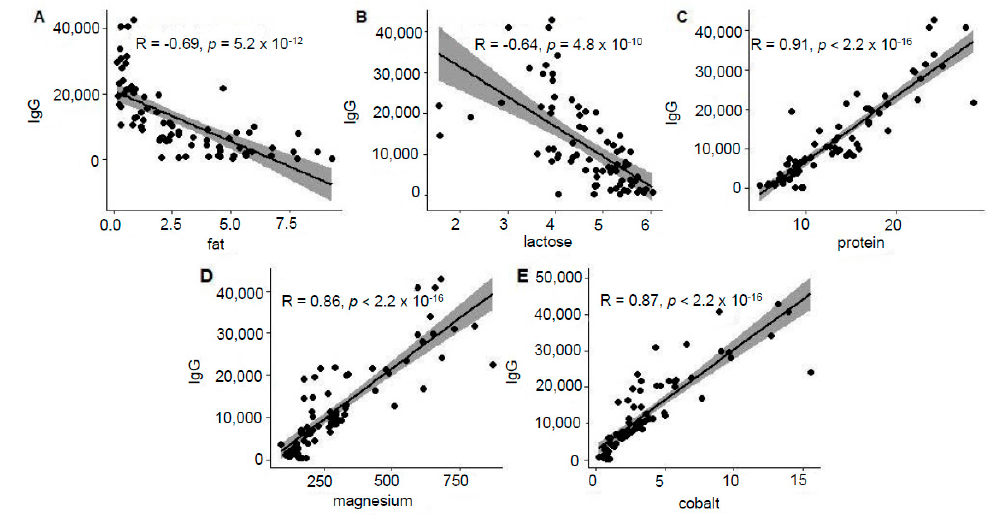
Figure 2. Associations between IgG and fat ( A ), lactose ( B ), protein ( C ), magnesium ( D ) and cobalt ( E ) concentrations in alpaca colostrum during four days after